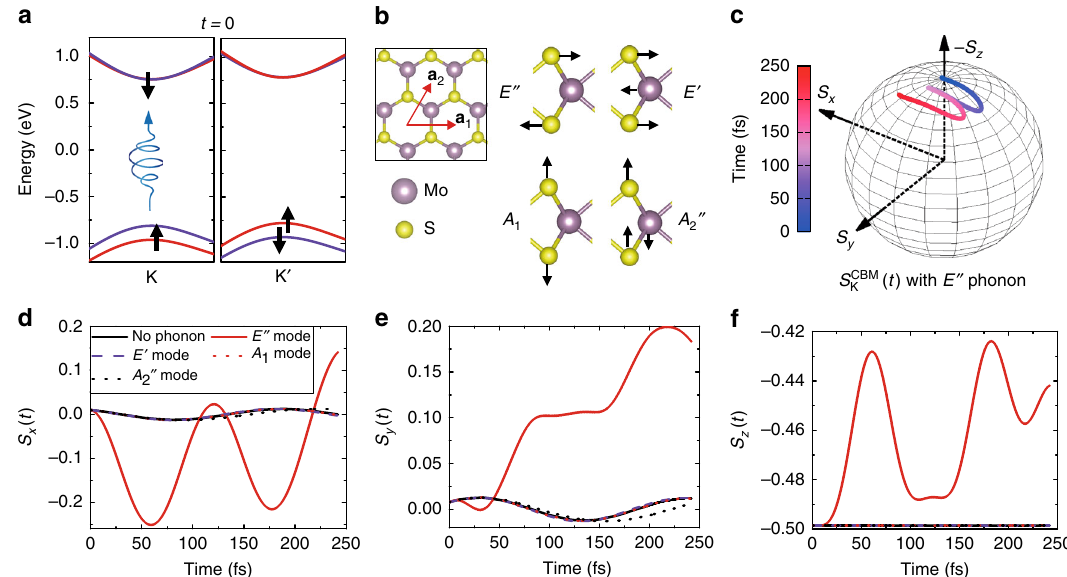
Fig. 1 TDDFT simulation of the spin-phonon dynamics of monolayer MoS 2 . a The initial electronic con fi guration used here with one electron excited at the K valley, for example, by right-handed light. b Top view of the solid and a side view of the eigenvectors of the four zone-center optical phonons. c The time trace of the spin vector of the CBM electron with the E ″ phonon being coherently excited. d – f The same time pro fi les of the Cartesian components of the spin with each of the phonon modes E ″ , E ′ , A 1 , A 2 ″ and with the frozen lattice. The full phonon dispersion is given in Supplementary Fig. 1. Here, all phonons are linearly polarized along the y